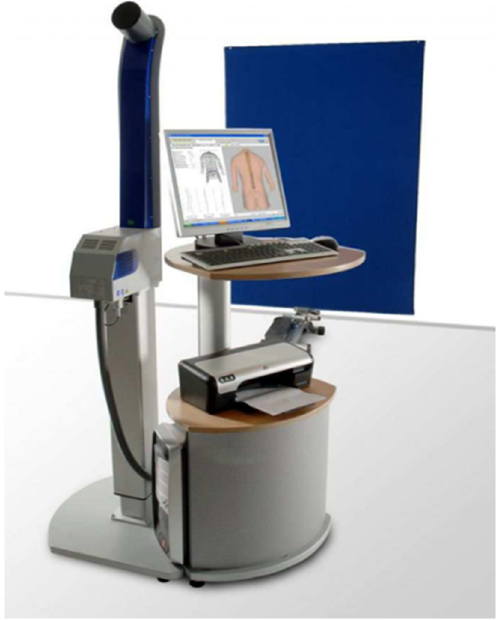
Figure 1. Diers Formetric III 4D.